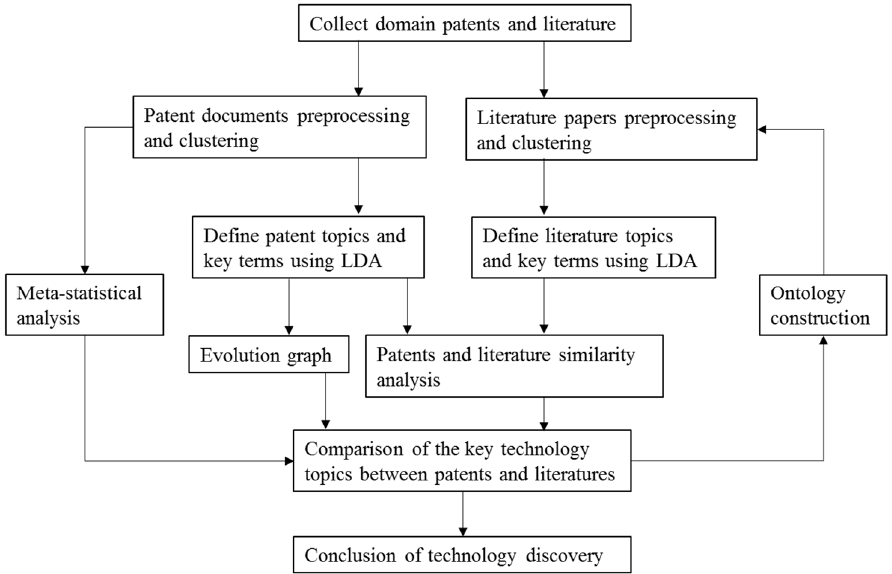
Figure 1. The research flowchart of the technology mining and analysis.